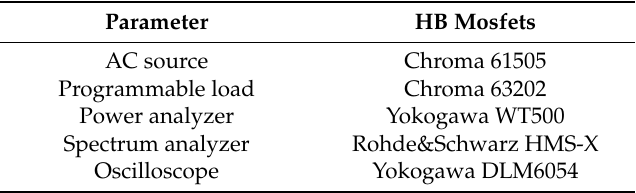
Table 4. List of equipment used for measurements.